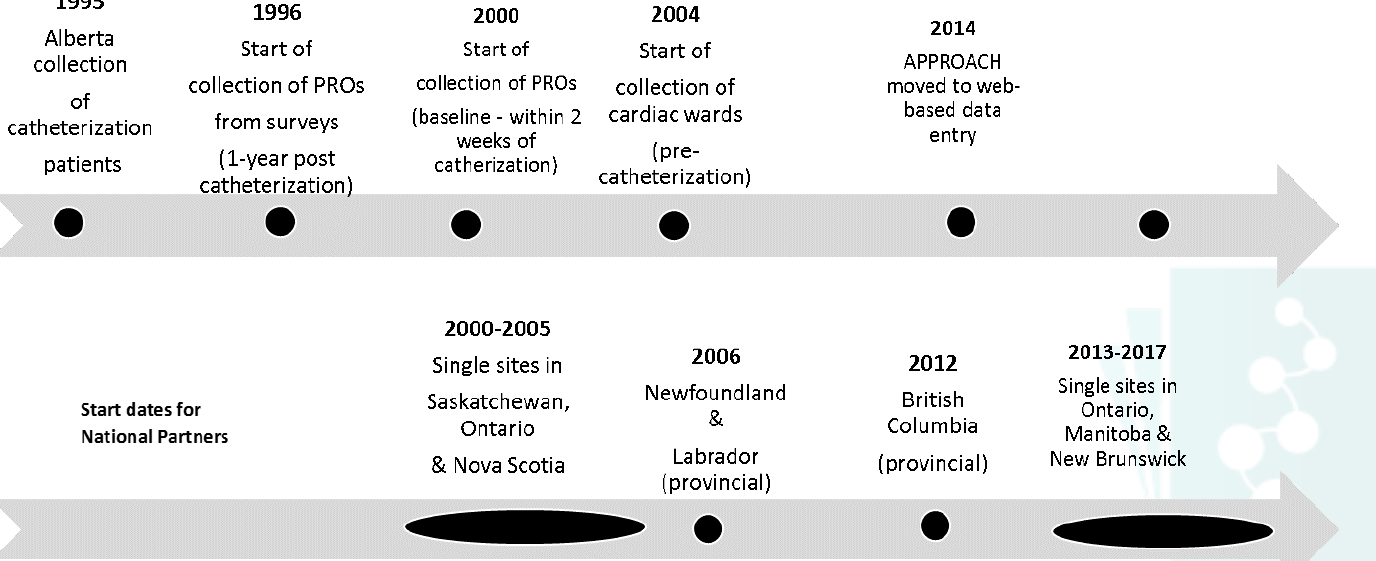
Figure 3: Geographic timeline of the Alberta Provincial Project for Outcome Assessment in Coronary Heart Disease